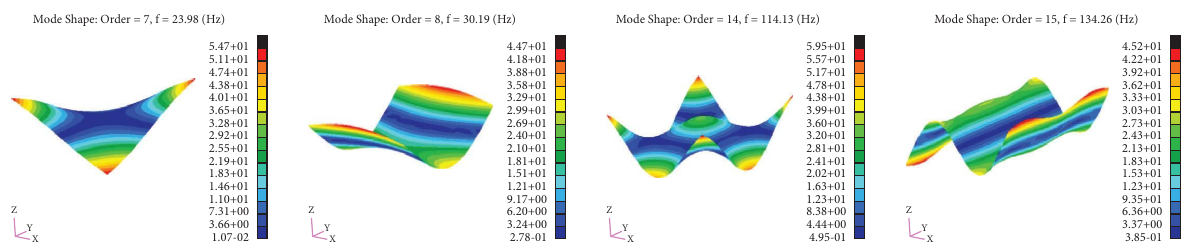
Figure 6: Normal mode analysis